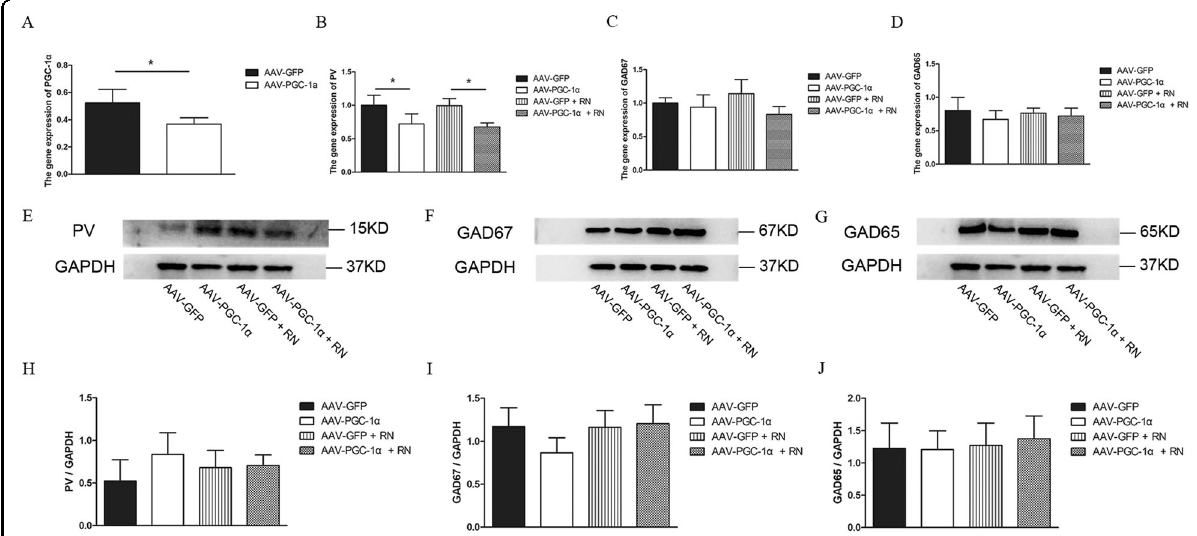
Fig. 3 Comparisons of the relative gene and protein expression results in the hippocampus of mice in different groups. A The gene expression of PGC-1 α in the AAV-GFP group ( n = 4) and the AAV-PGC-1 α group ( n = 4) (mean ± SD). * indicates p < 0.05. B – D The gene expression of PV, GAD65 and GAD67 in the AAV-GFP group ( n = 4), AAV-PGC-1 α group ( n = 4), AAV-GFP + RN group ( n = 4) and AAV-PGC-1 α + RN group ( n = 3) (mean± SD). * indicates p < 0.05. E – G The protein expression levels of PV, GAD67, and GAD65 in the hippocampus of mice in the AAV-GFP group ( n = 5), AAV-PGC-1 α group ( n = 5), AAV-GFP + RN group ( n = 5), and AAV-PGC-1 α + RN group ( n = 5) were detected using western blots. H – J Semiquantitative analyses of the protein levels of PV, GAD67, and GAD65 in the hippocampus of mice in the AAV-GFP group ( n = 5), AAV-PGC- 1 α group ( n = 5), AAV-GFP + RN group ( n = 5), and AAV-PGC-1 α + RN group ( n = 5) (mean ±